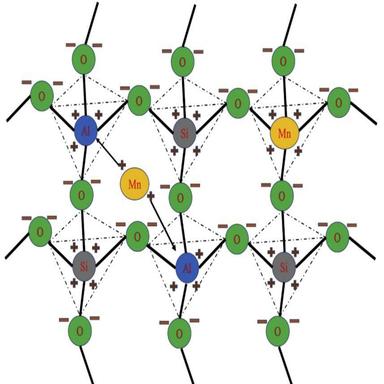
Charge balance effect consolidation of manganese in the Si-Al system.